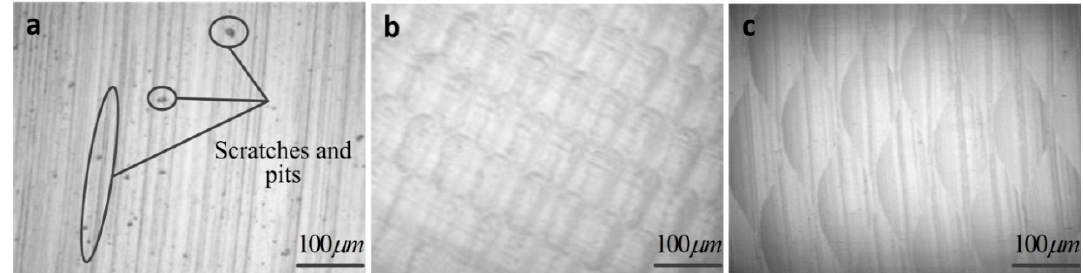
Figure 6. Surface topography during different processing method. ( S = 70 mm/min, A = 7 μ m, D = 1 μ m and F = 0.2 mm·min − 1 ) ( a ) Traditional continuous cutting (TCC) method; ( b ) Two-dimensional elliptical vibration cutting (2D-EVC) method with the vibration frequency of the tool tip f 2D = 50 Hz; ( c ) The non-resonant three-dimensional elliptical vibration cutting (3D-EVC) method with the